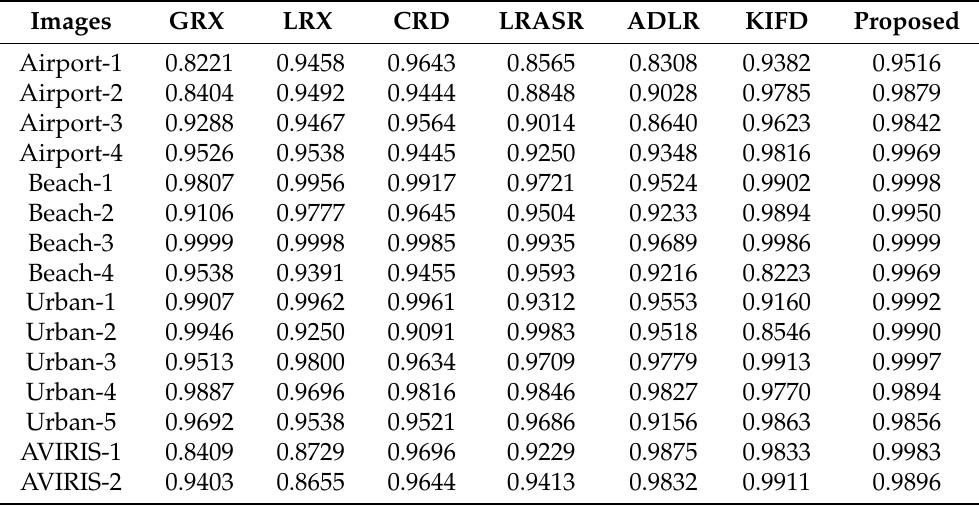
Table 1. AUC Scores of the compared AD algorithms on ABU and AVIRIS data